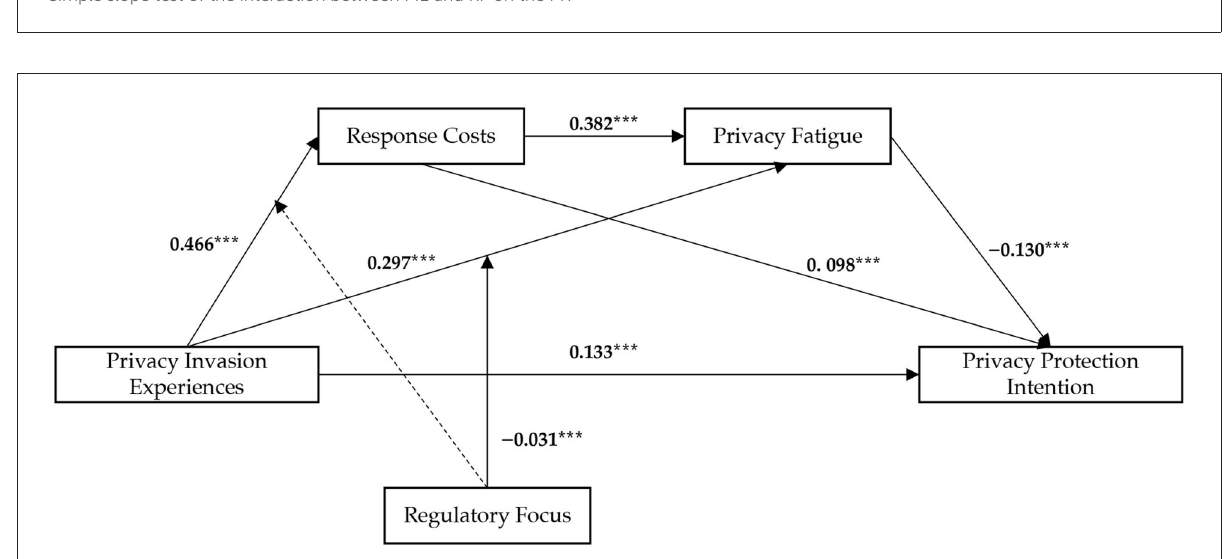
FIGURE3 The moderated chain mediation model. Dashed lines represent nonsignificant relations *** p <